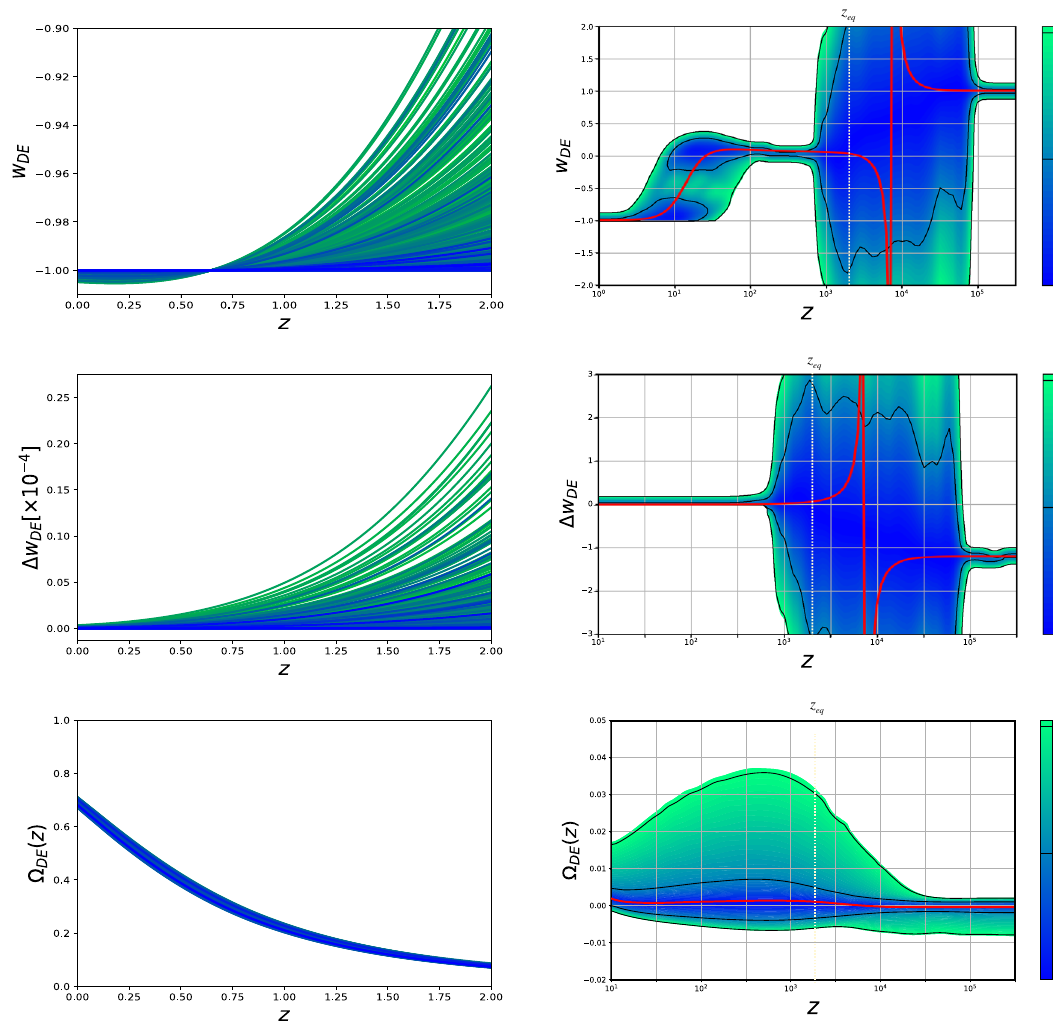
lines to the redshift of matter-radiation equality. (Top) ¯ w DE ( z ) at low z values (left) and at high redshift values in log-scale (right). (Middle) (cid:8)w ( z ) at low z values (left) and at high redshift values in log-scale DE (right).(Bottom) (cid:4) DE ( z ) atlow z values(left)andathighredshiftvalues in log-scale